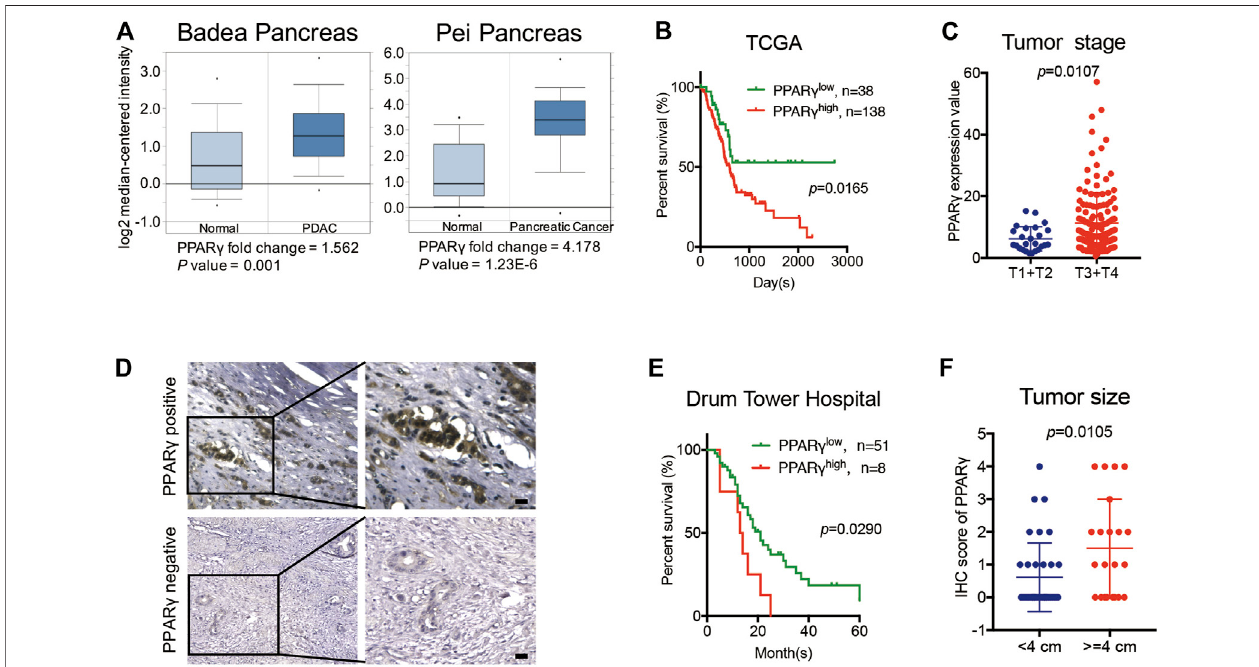
FIGURE 1 | High expression of PPAR γ in nuleus is correlated with poor prognosis in PDAC. (A) The expression of PPAR γ increased in pancreatic cancer tissue compared to adjacent normal pancreatic tissue by Oncomine datasets analysis. (B) In TCGA dataset, high expression of PPAR γ in cancer tissues was associated with shorteroverallsurvivaltimeinthePDACpatients( p= 0.0165). (C) InTCGAdataset,PPAR γ expressionlevelwaspositivelycorrelatedwithtumorstages( p= 0.0107). (D) PPAR γ immunostaining signal in pancreatic cancer tissues was primarily detected in nucleus. The scale bar was 20 μ m. (E) High expression level of PPAR γ in pancreatic cancer tissues was associated with shorter overall survival time in the PDAC patients ( p = 0.0290). (F) PPAR γ expression level was positively correlated with tumor size ( p =